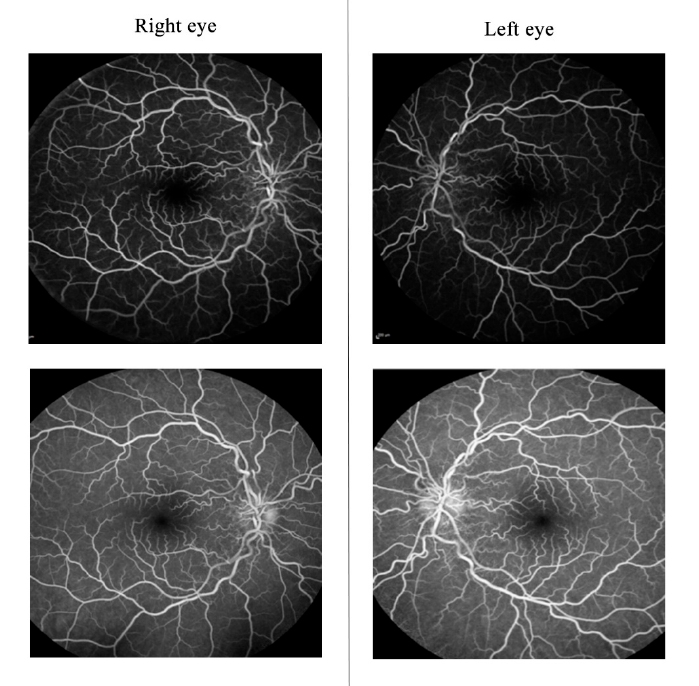
Figure 3. Fluorescein angiography showing tortuous bilateral telangiectatic vessels and late disc staining with no dye leakage.